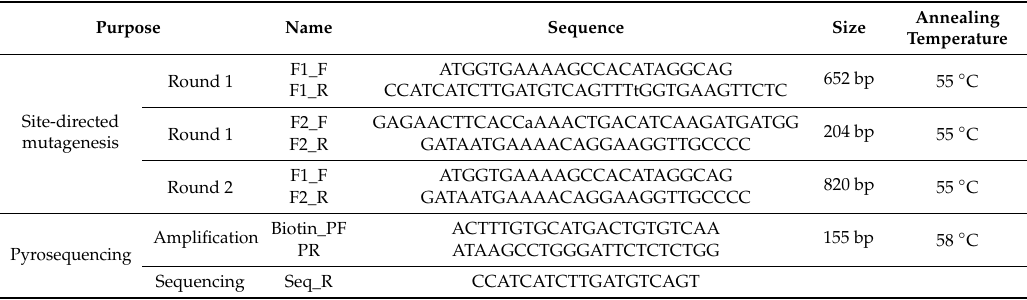
Table 2. Detailed information on the primer set